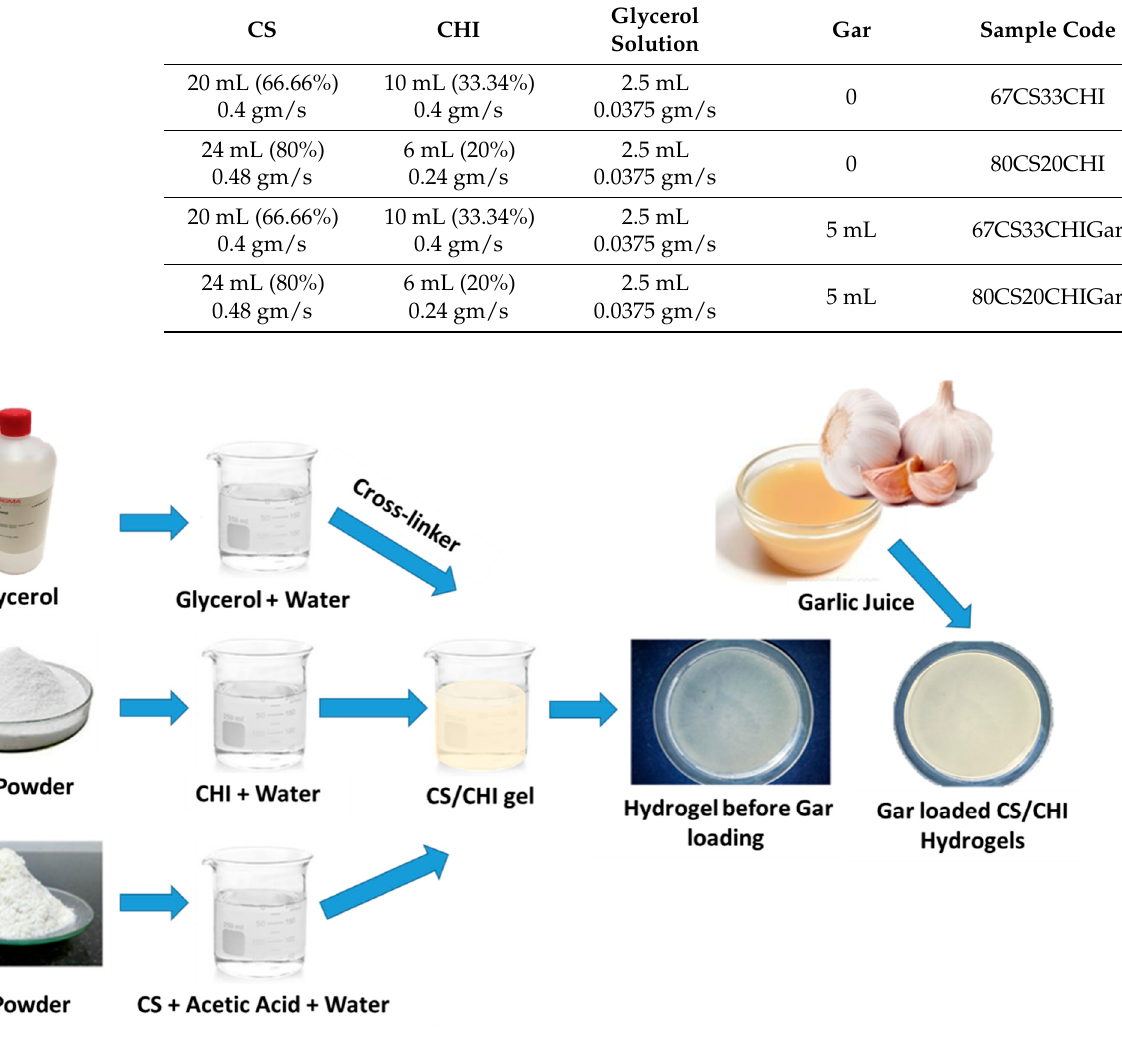
Figure 6. Synthesis mechanism of Gar loaded CS and CHI based hydrogels. Table 3. Composition of CS, CHI, Gar and glycerol in hydrogels.